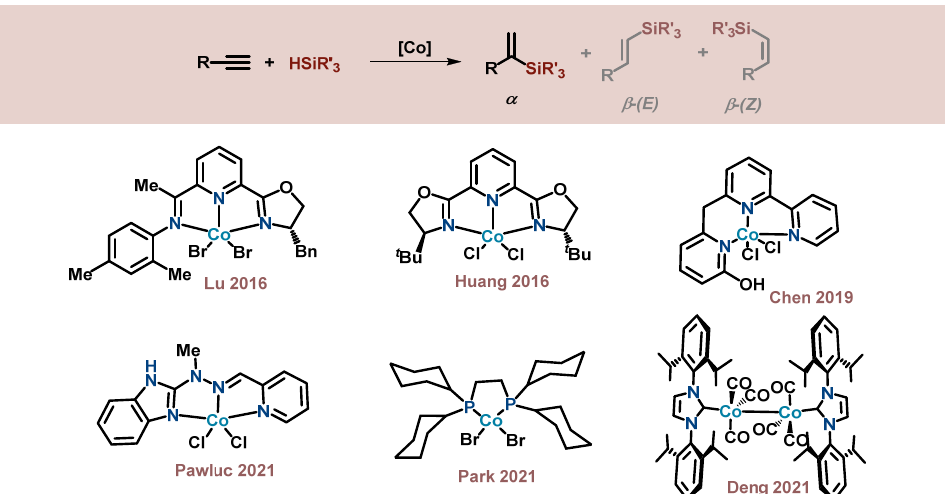
Figure 1. Selected examples of cobalt-based catalysts for α -selective hydrosilylation of alkynes [22– 28].